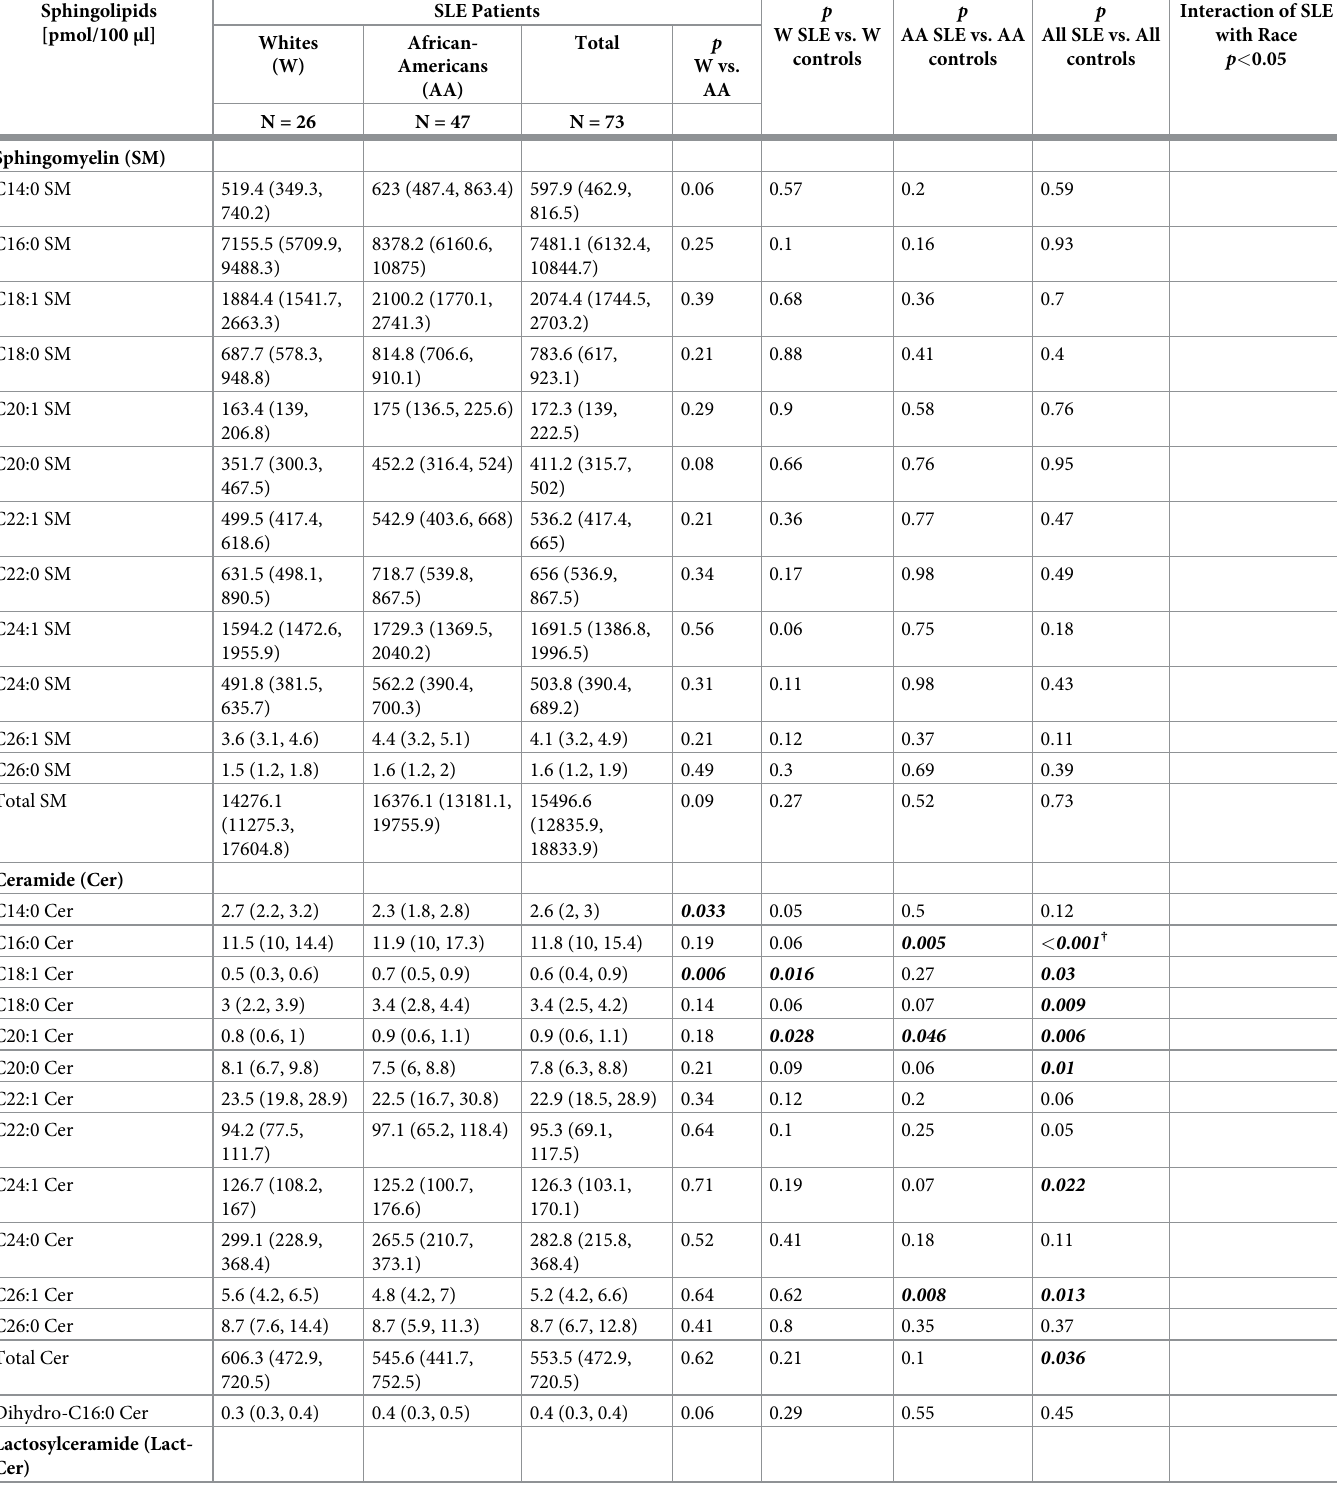
Table 3. Sphingolipid concentration in plasma of White and African-American SLE patients compared to sphingolipid concentration in plasma of healthy White and African-American control subjects presented in Table 2. Sphingolipids [pmol/100 μ l]